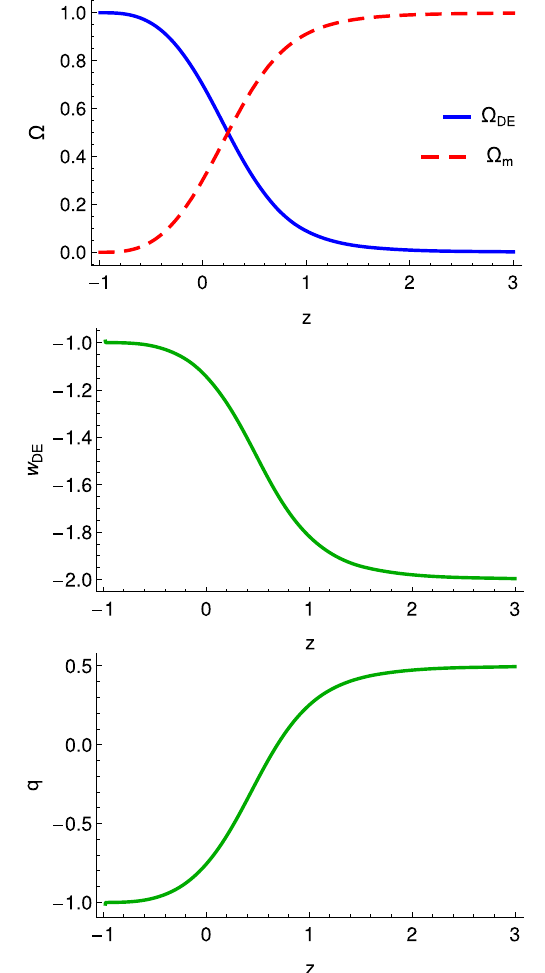
Fig. 1 Upper graph: The evolution of the effective dark energy den- sity parameter (cid:4) DE (blue-solid) and the matter density parameter (cid:4) m (red-dashed) respectively, as a function of the redshift z , for the modi- fied scenario through Kaniadakis entropy, in the case of (cid:2) = 0. Mid- dle graph: The evolution of the effective dark energy equation-of-state parameter w DE . Lower graph: Evolution of the deceleration parameter q . In all graphs the Kaniadakis entropic parameter is K = 0 . 35 in units of k B , and according to (30) (cid:4) m 0 ≈ 0 . 3